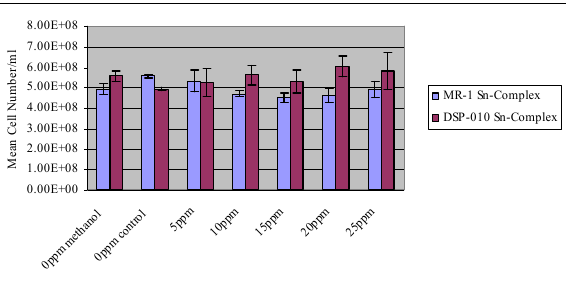
Figure 3: Effects of various concentrations of diphenyl Sn- thiosemicarbazone metal complex on Shewanella oneidensis MR-1 and DSP-010 grown aerobically in LB broth. Mean cell/ml was determined at 37 ˚ C after a 48 hour time period for three independent experiments. Error bars are for standard